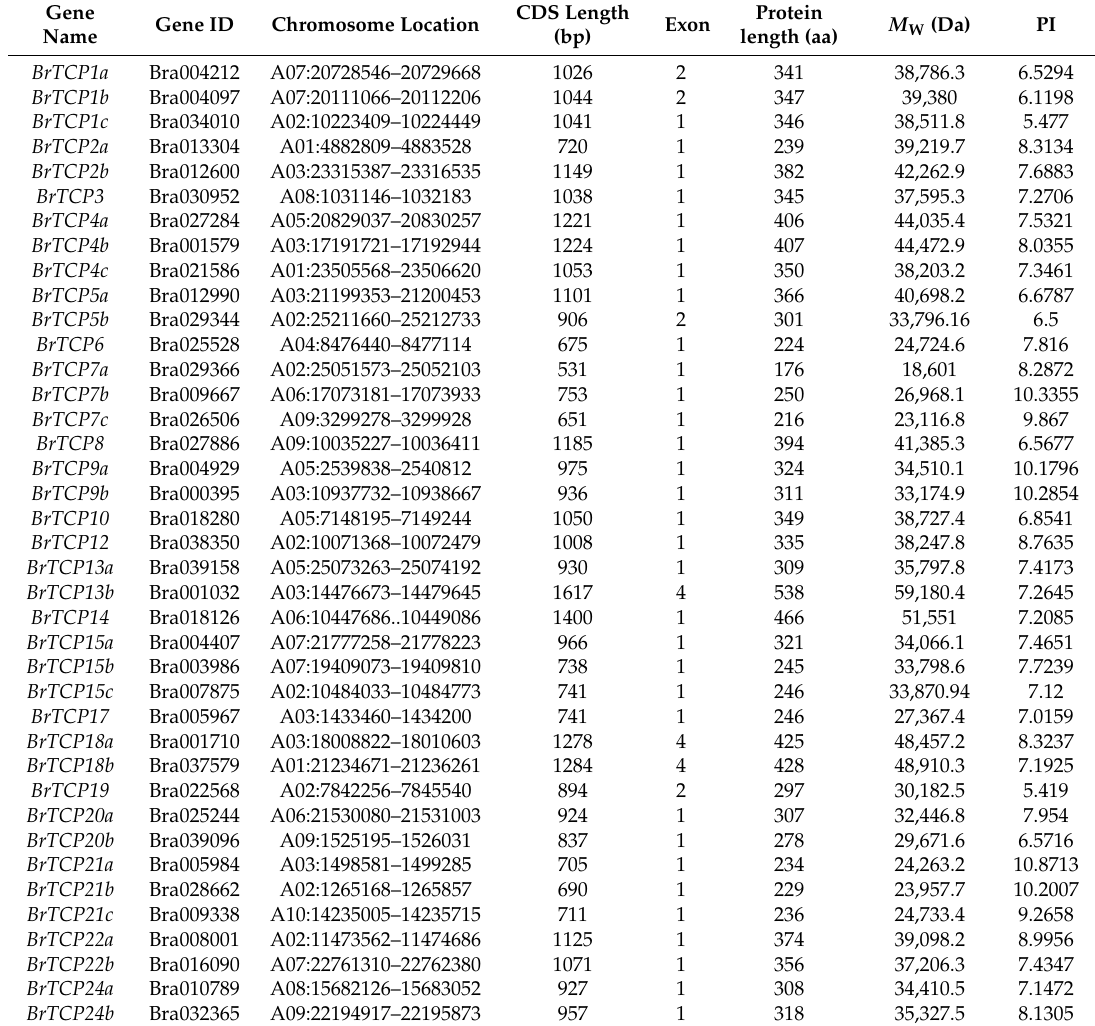
Table 1. TCP family transcription factor genes in Chinese